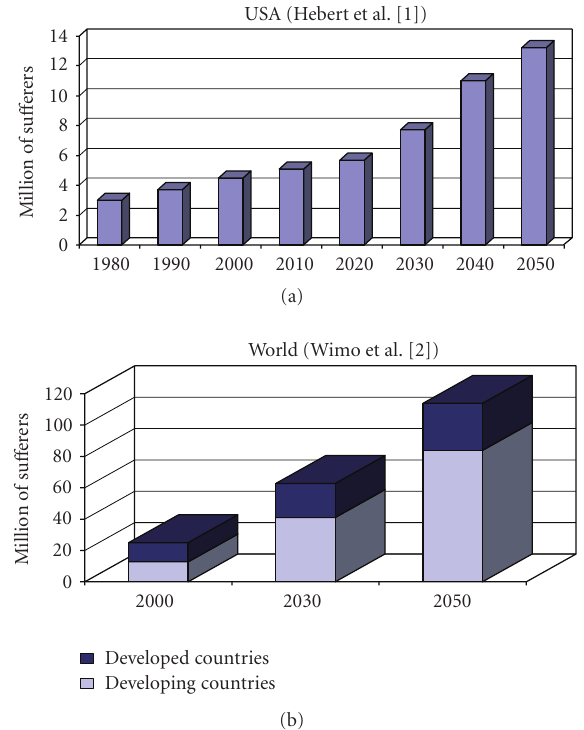
Figure 1: Projection of the prevalence of AD and dementia in the near future. Illustration based on demographic estimates of Hebert et al. [1] (projection of AD prevalence in USA) and Wimo et al. [2] (projection of AD prevalence